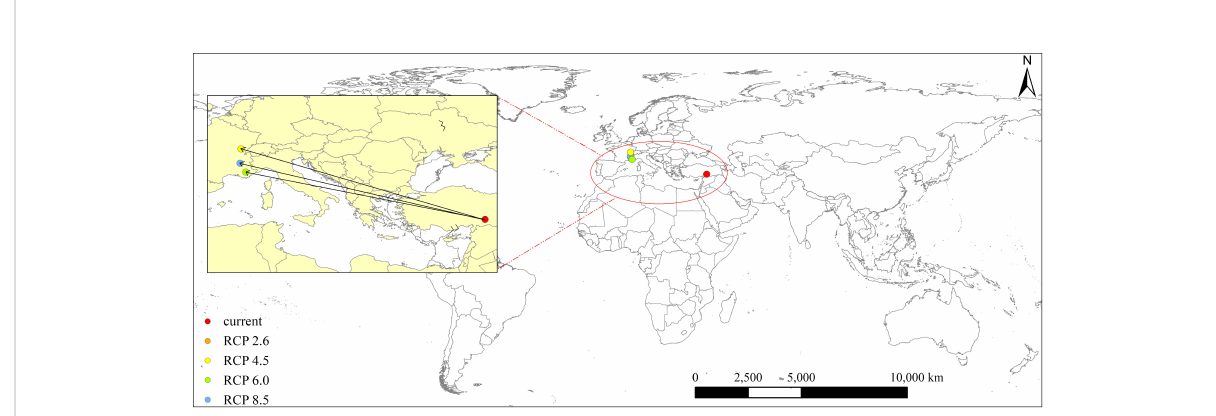
FIGURE 6 Distribution center shifts of Lolium temulentum under the current and future climate